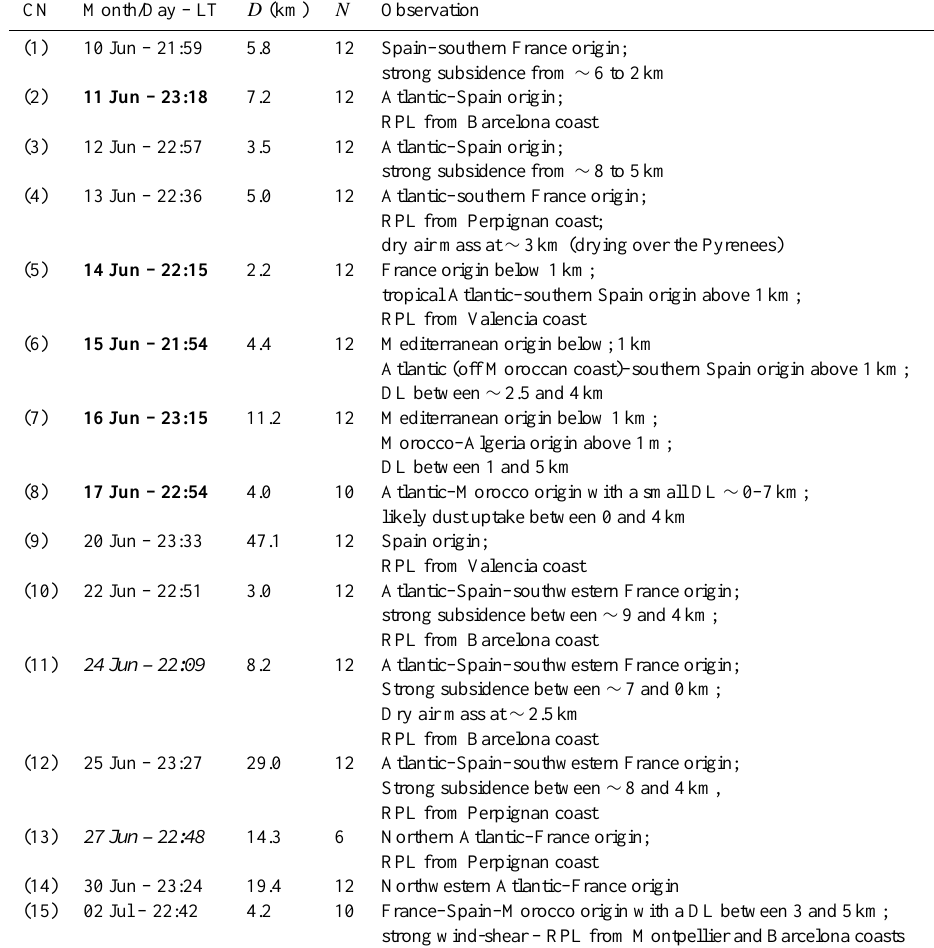
Table 3. Same as Table 2 for the ChArMEx experiment (2013 summer period).